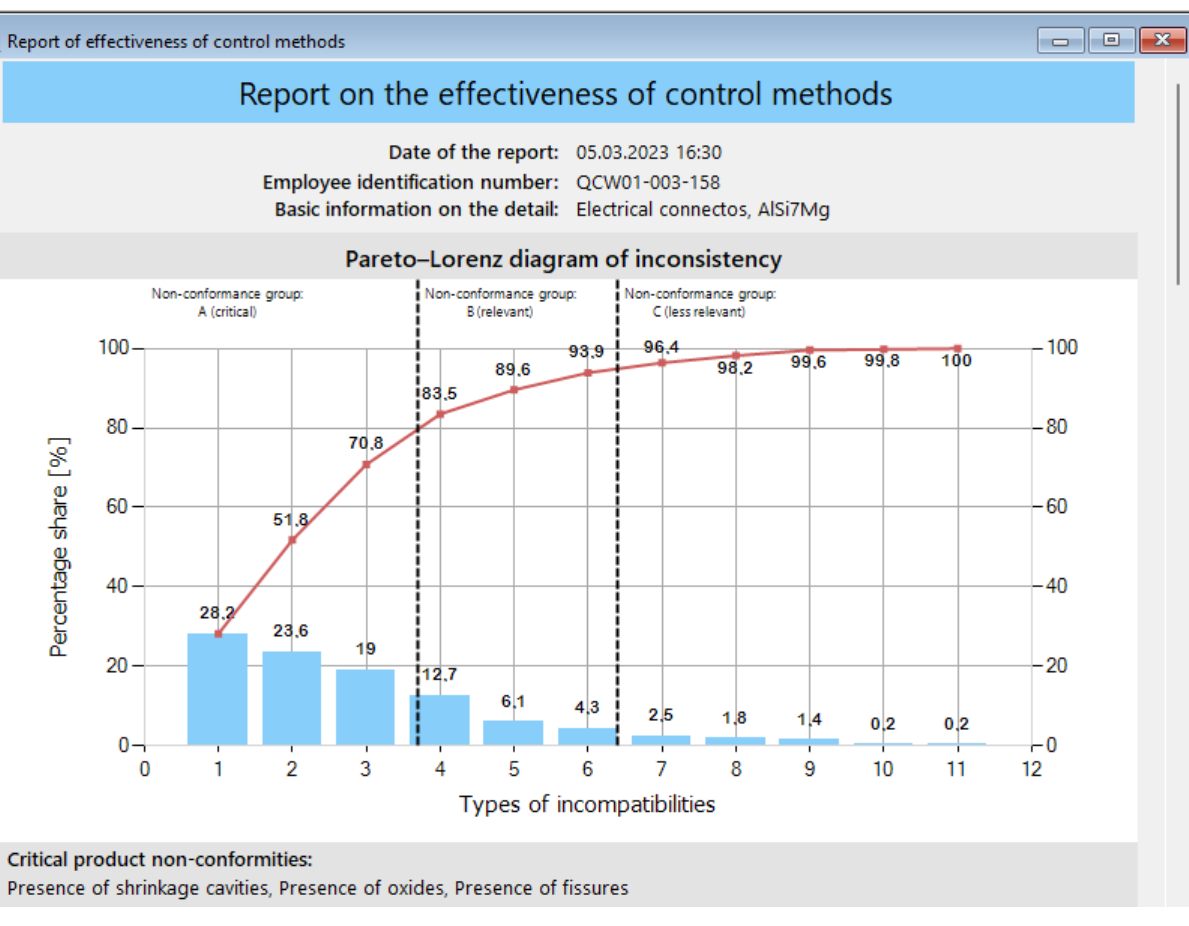
Figure 6. Part one of the report on the effectiveness of control methods: Pareto–Lorenz chart. The markings on the horizontal axis of the graph indicate control methods identical to those in Figure 5.